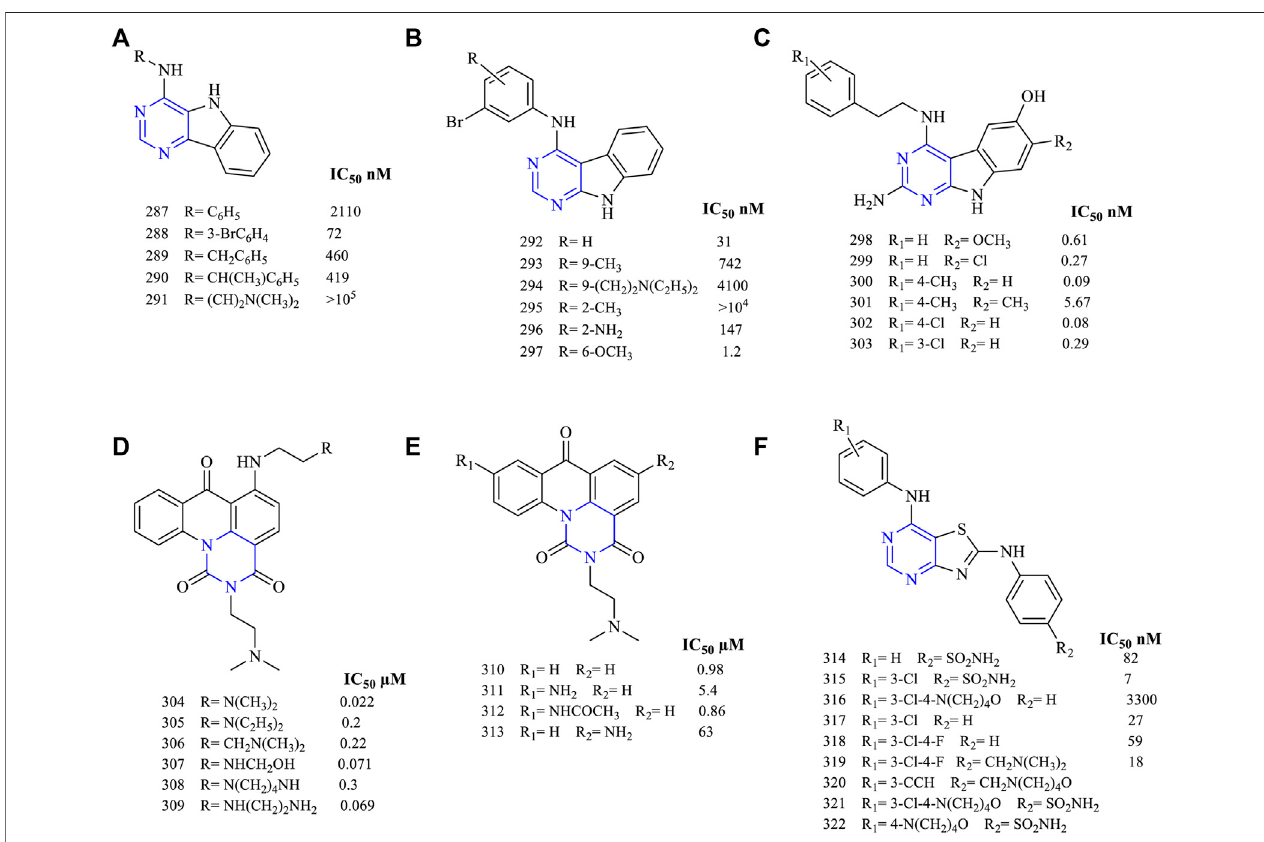
FIGURE 20 | Chemical structures of (A) pyrimido [5,4- b ]indol-4-amine, (B) N -phenylpyrimido [5,4- b ]indol-4-amine, (C) 2-amino-4-(phenylethylamino) pyrimido [4,5- b ]indole, (D) 6-substituted pyrimido [5,6,1-de]acridin-1,3,7-trione, (E) 9-substituted pyrimido [5,6,1- de ]acridin-1,3,7-trione), and (F) 4,6-diaminothiazolo [4,5- d ]